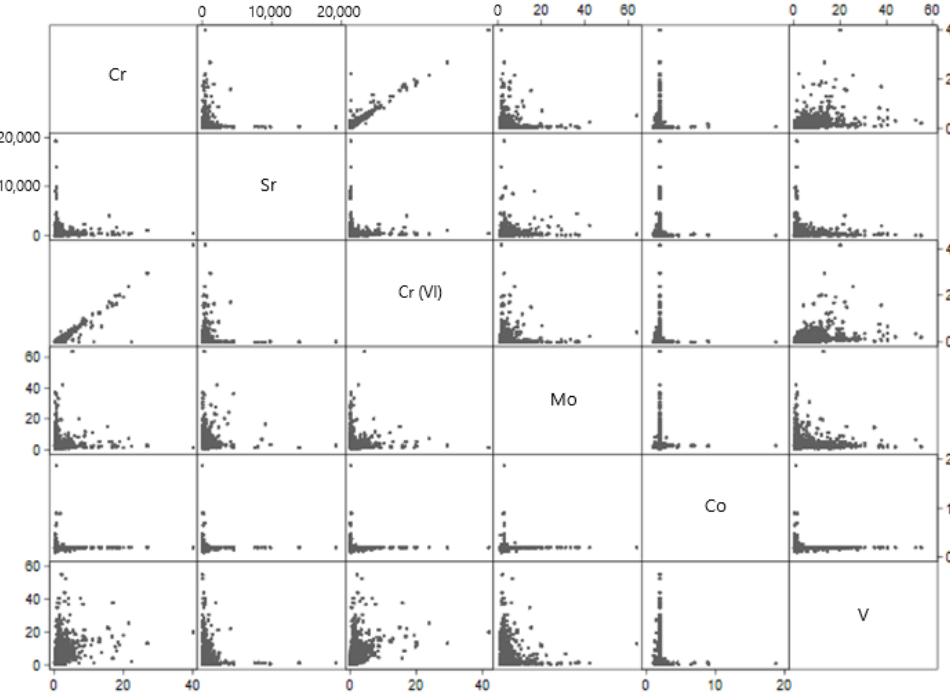
Figure 1. Predicted large public water system-level geometric means of contaminants. Large water system-level geometric means were obtained from mixed-effect Tobit regression models fitted to each contaminant separately, with two random intercepts accounting for nesting of water samples within water systems within states. Each axis corresponds to the contaminants’ range of geometric means (µg/L). Table 3. Pairwise correlations of predicted geometric means of small public water systems ( ≤ 10,000 people served) by contaminant with p value for the correlation on the second line. Variables